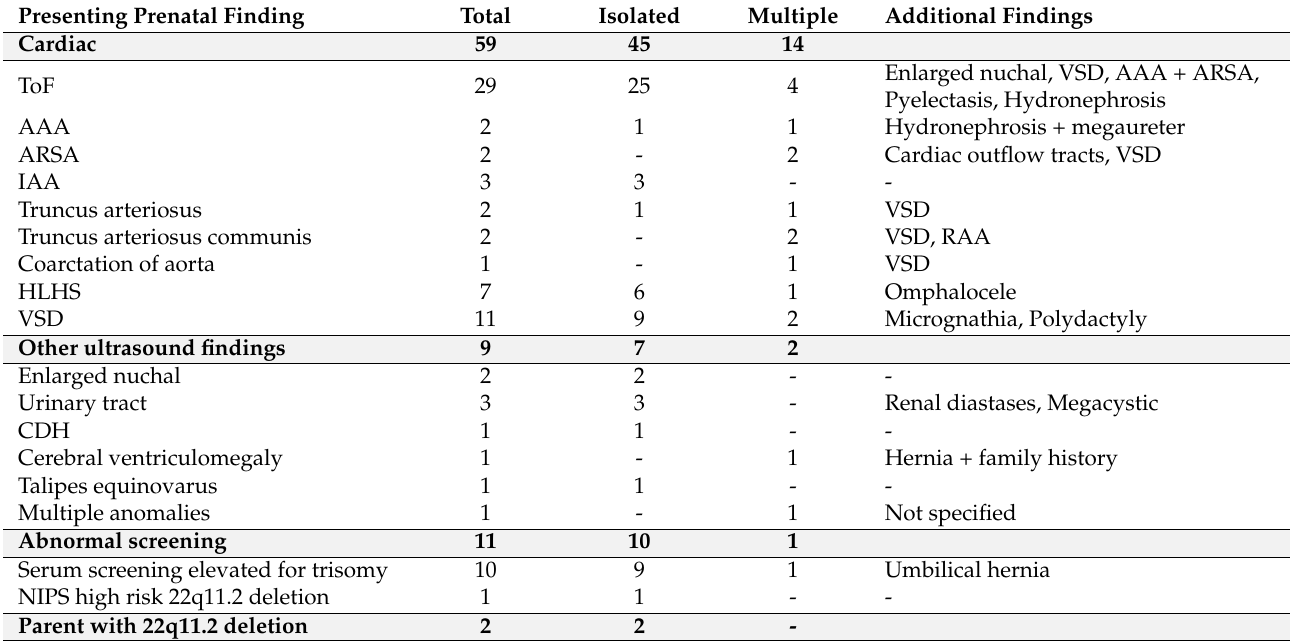
Table 3. Prenatal diagnostic findings: n = 80 identified to have a 22q11.2 deletion at Institute of Mother and Child, Warsaw,